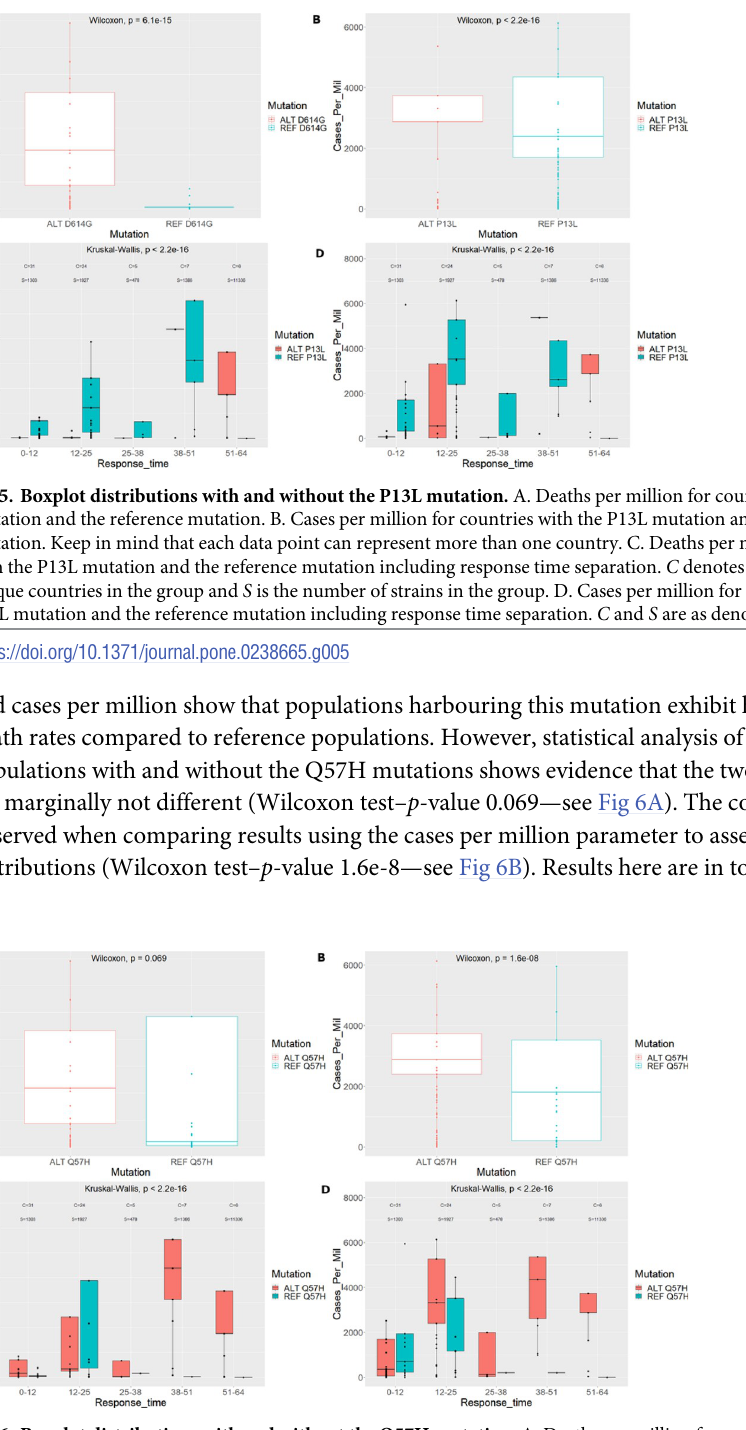
Fig 6. Boxplot distributions with and without the Q57H mutation. A. Deaths per million for countries with the Q57H mutation and the reference mutation. B. Cases per million for countries with the Q57H mutation and the reference mutation. C. Deaths per million for countries with the Q57H mutation and the reference mutation including response time separation. C denotes the number of unique countries in the group and S is the number of strains in the group. D. Cases per million for countries with the Q57H mutation and the reference mutation including response time separation. C and S are as denoted for panel C.